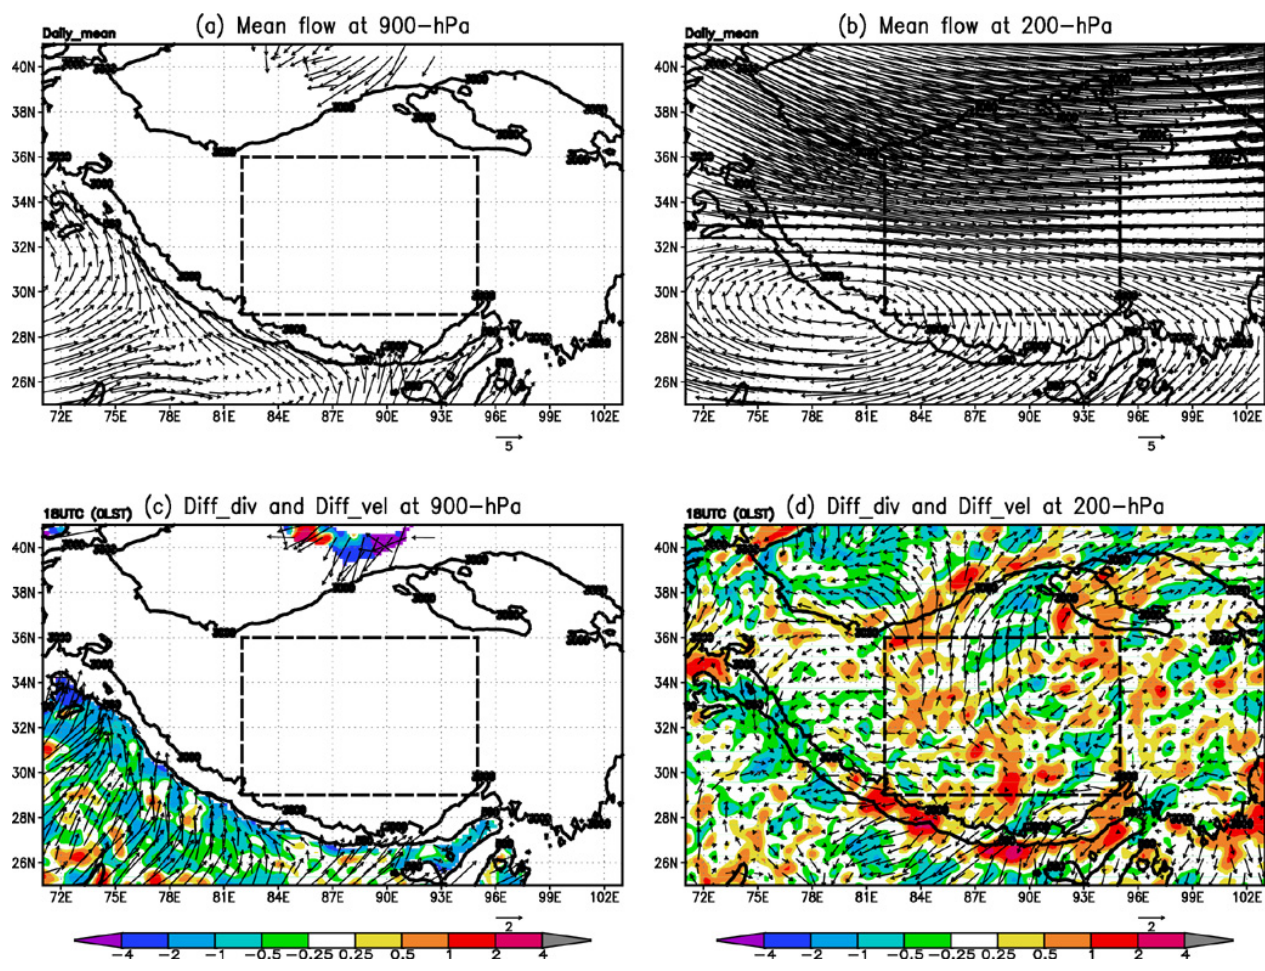
Fig. 13. Daily-mean velocity field (vectors) at levels: (a) 900hPa, (b) 200hPa; Diurnal variations (18:00UTC minus daily mean) of diver- gence ( × 10 − 5 s − 1 , shadings) and velocity field (vectors) at levels: (c) 900hPa, (d)